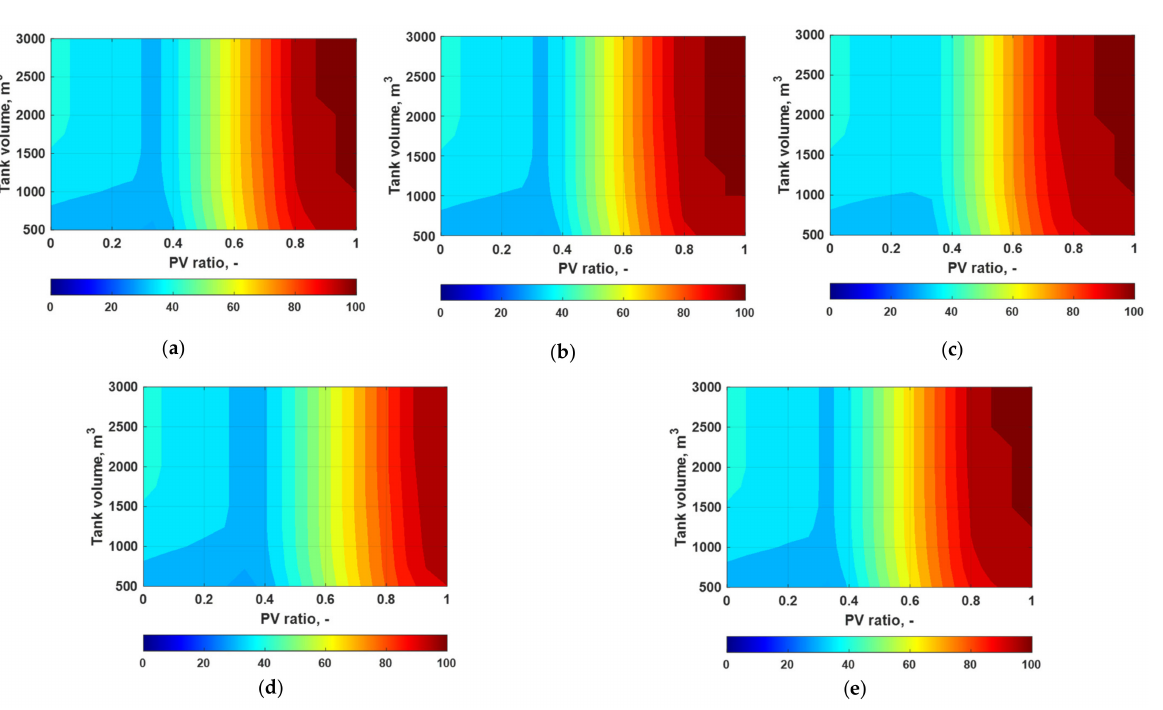
Figure 11. SCR (%) for cherries in Silistra with 15 kW HRES and WT type 4 for each PV cell technology: ( a ) mSi; ( b ) pSi; ( c ) uSi; ( d ) CIGS; ( e )